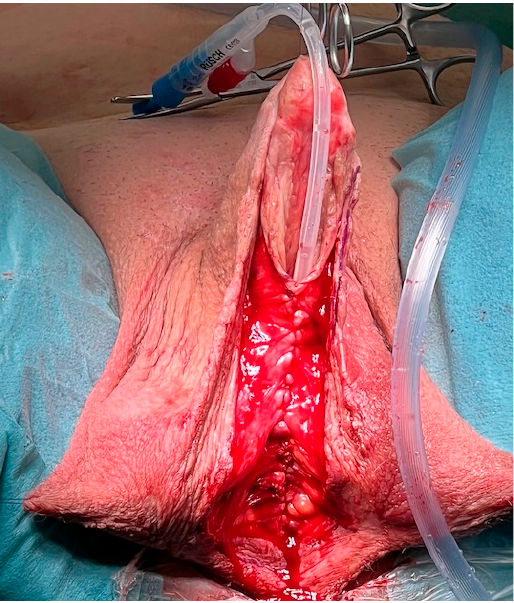
Figure 9. Closure of the neourethra with inverted running sutures.